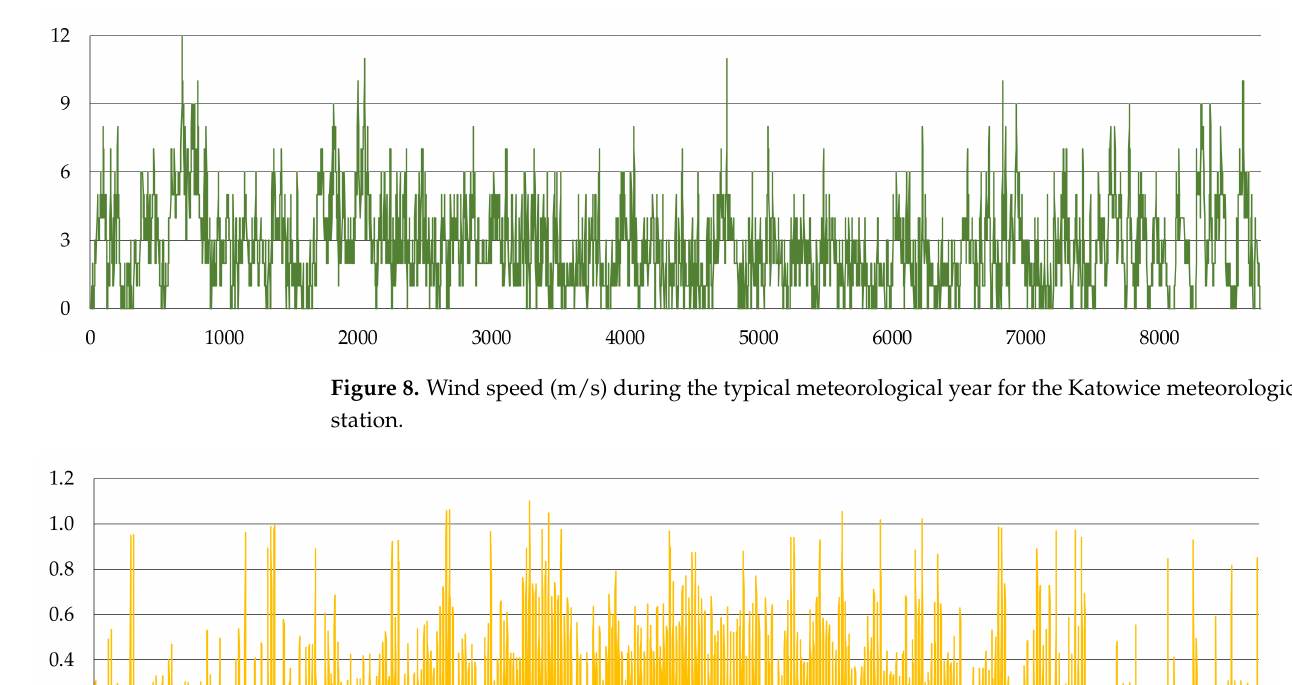
Figure 7. Ambient temperature ( ◦ C) during the typical meteorological year for the Katowice meteo- rological station.